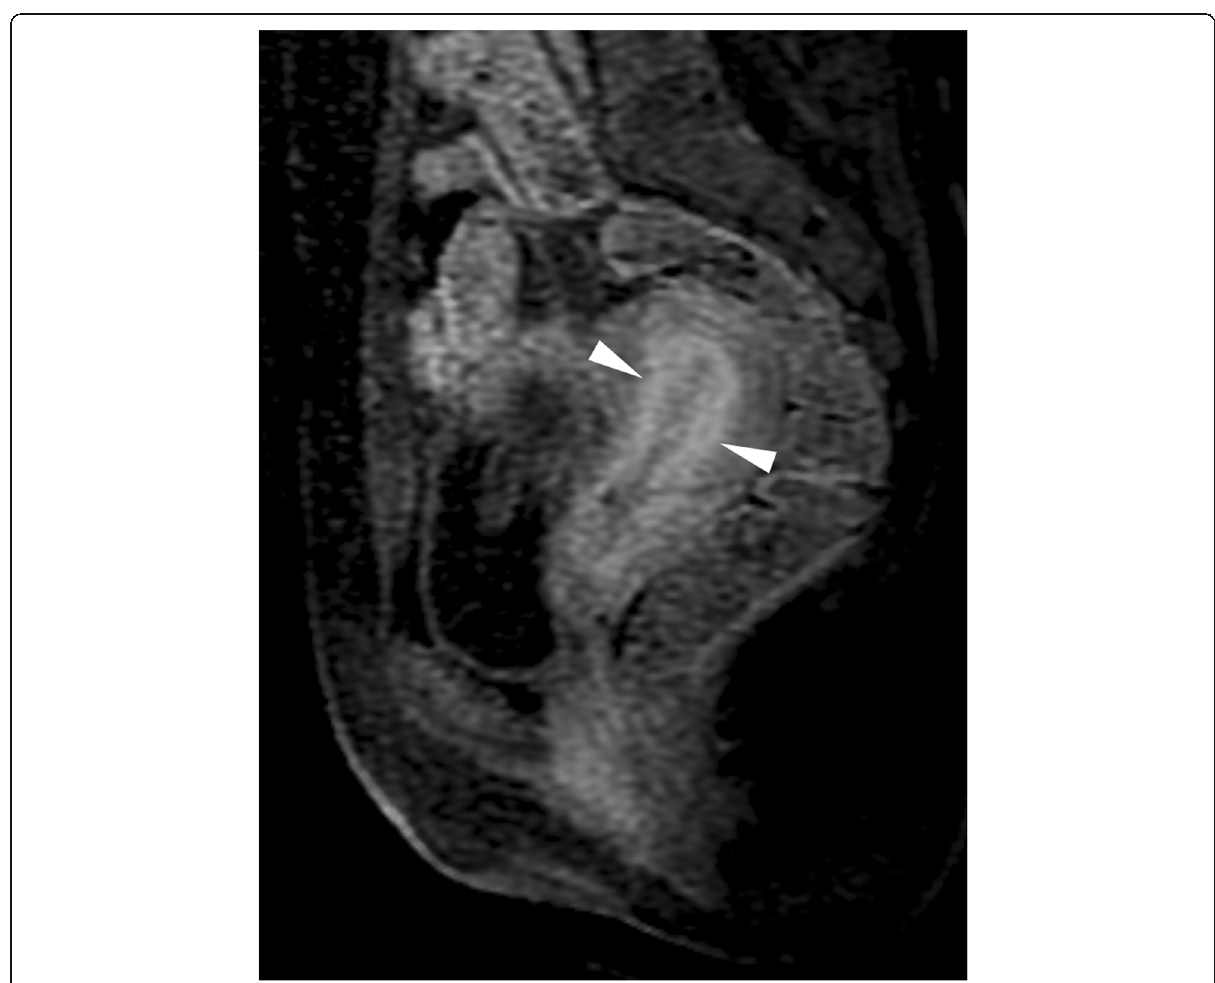
Fig. 11 MRI appearance of endometritis in a 38-year-old woman with pelvic pain. Sagittal gadolinium-enhanced fat-suppressed T1-weighted image shows contrast enhancement of the endometrium and inner myometrial layer